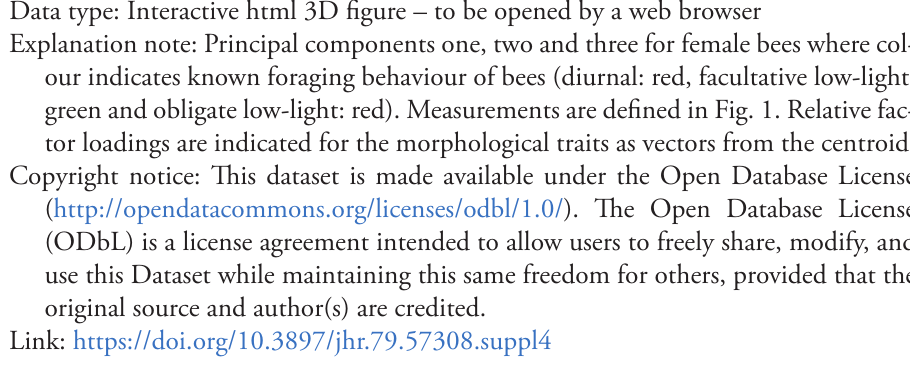
Data type: Interactive html 3D figure – to be opened by a web browser Explanation note: Principal components one, two and three for female bees where col- our indicates known foraging behaviour of bees (diurnal: red, facultative low-light: green and obligate low-light: red). Measurements are defined in Fig. 1. Relative fac- tor loadings are indicated for the morphological traits as vectors from the centroid.